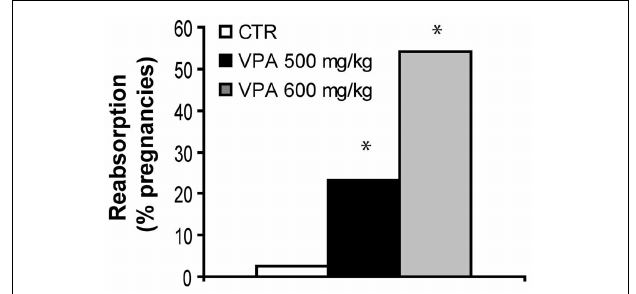
FIGURE 1 | Fetal reabsorption rates for control (CTR), VPA 500mg/kg and, VPA 600mg/kg. ∗ Indicate VPA doses with higher rates than CTR. Data shown as percent of